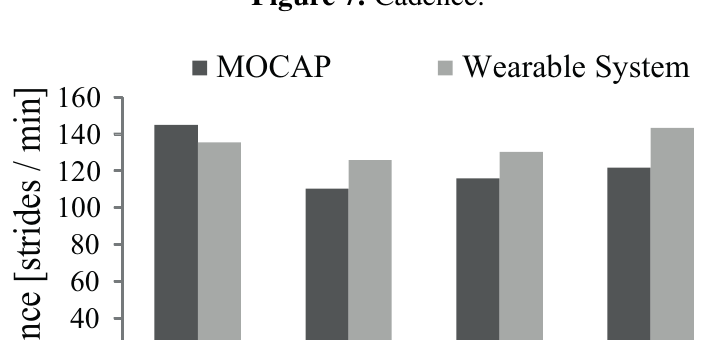
Figure 7. Cadence.